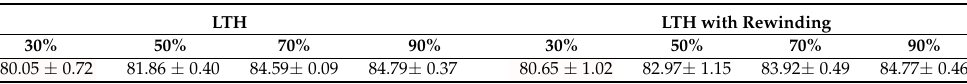
Table 5. Results of performing LTH and LTHR experiments on ResNet-18 trained on CALTECH-101. Mean and standard deviation of accuracy over 3 rounds are reported. The darker the shade of red, the further the accuracy is from the baseline.